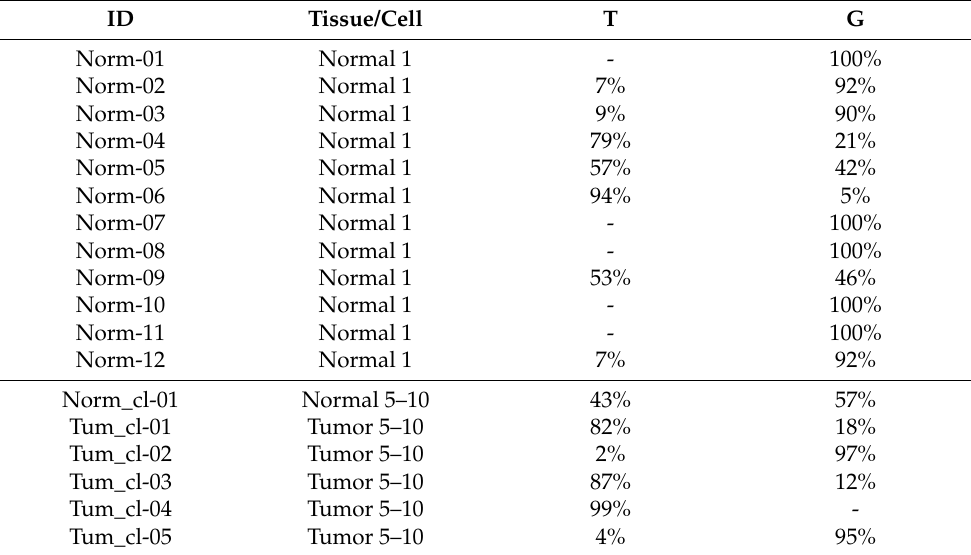
Table 3. NGS results of normal and tumor samples with single cells and clusters of 5–10 cells.